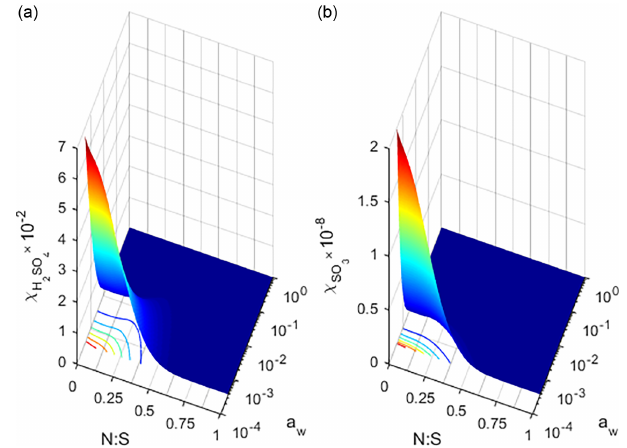
Figure 2. Modelled particle-phase mole fractions of (a) H 2 SO 4 ( aq ) , χ H , as a function of the water activity , and (b) SO 3 ( aq ) , χ SO 3 2 SO 4 ( a w ) and the N:S for Case 2a which represents the combination of H 2 SO 4 , H 2 O and SO 3 evaporating species with H 2 SO 4 being the dominating evaporating S(VI) species. The colour-coded contours on the x – y axes represent constant particle-phase mole fractions = 1–6 × 10 − 2 and (b) χ = 0.3–1.8 × 10 − 8 . The for (a) χ H SO 3 2 SO 4 = 2.40 × 10 9 molkg − 1 , and equilibrium coefficients are K H 2 SO 4 x K = 1.43 × 10 10 at T = SO 3